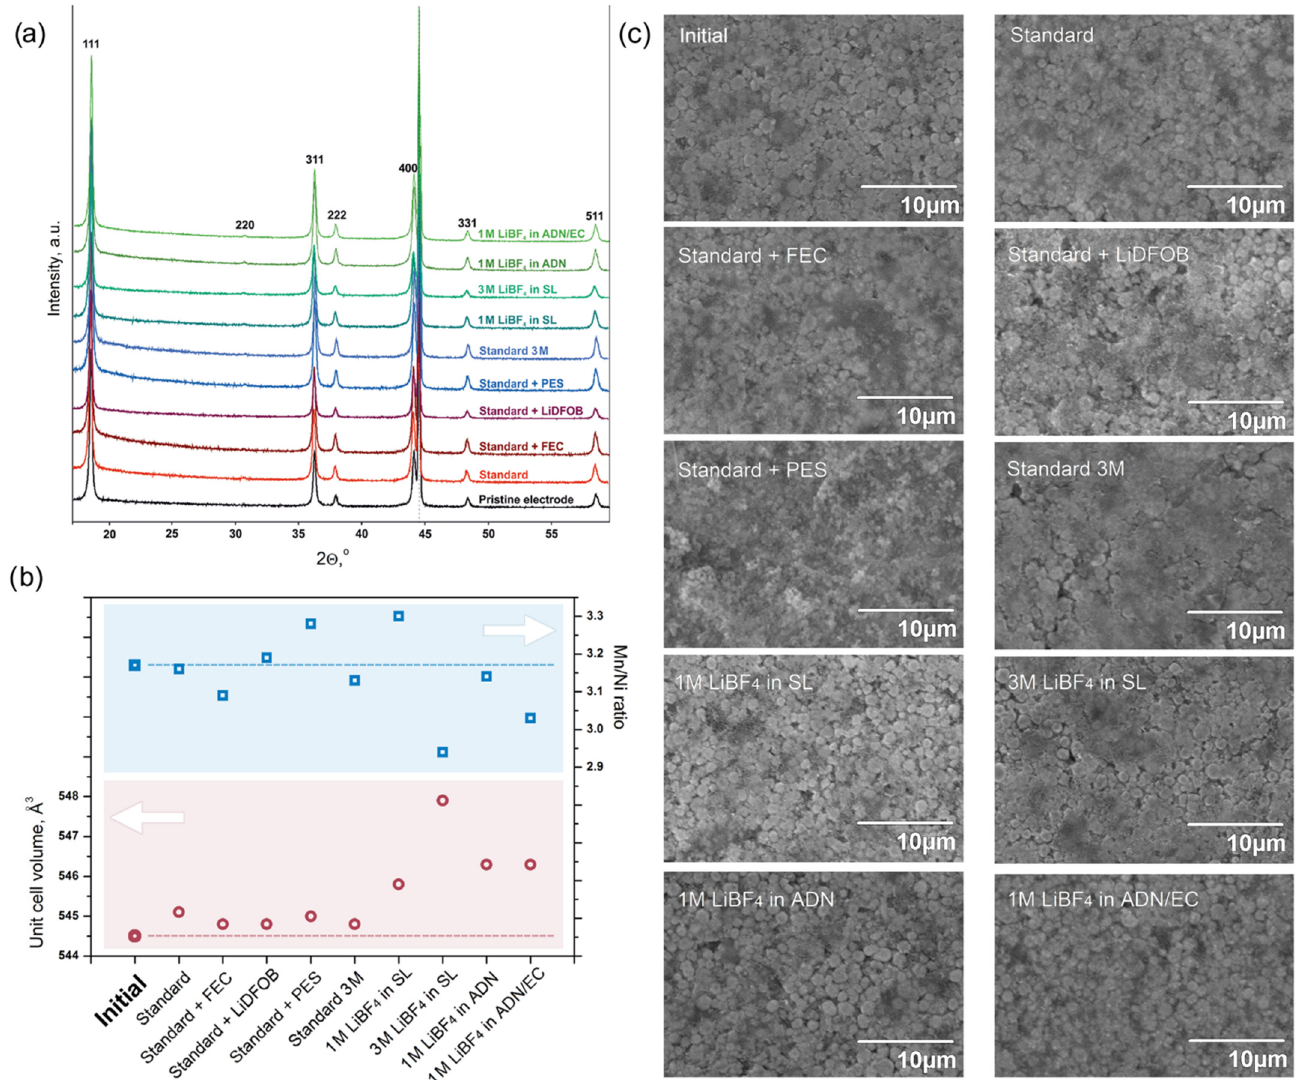
Figure 5. ( a ) Selected region of the ex situ PXRD patterns obtained for the pristine LiNi 0.5 Mn 1.5 O 4 cathode and for cathodes after 140 charge–discharge cycles in the selected electrolytes. The dotted line marks the Al current collector diffraction maximum. The reflections of cubic spinel LiNi 0.5 Mn 1.5 O 4 are indexed. ( b ) Unit cell volume and the Mn/Ni ratio of the LiNi 0.5 Mn 1.5 O 4 cathode material after 140 charge–discharge cycles in the selected electrolytes. ( c ) SEM images of the electrodes’ surface after